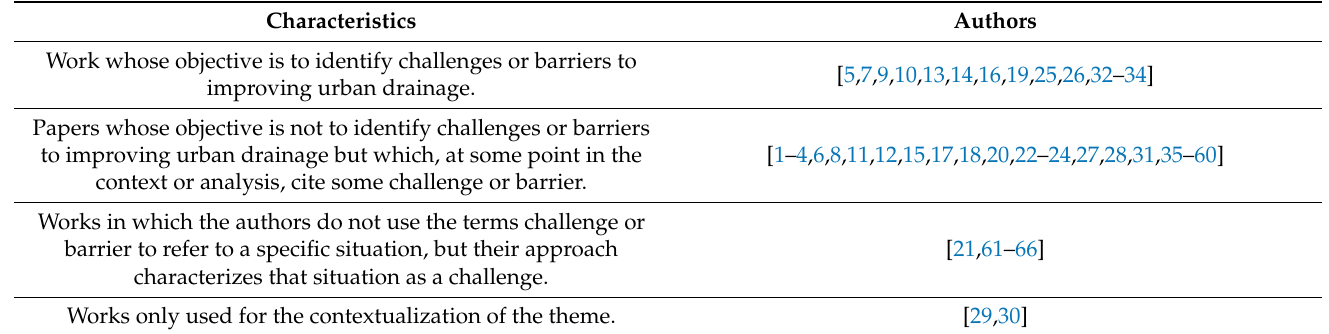
Table 1. Characteristics of the selected